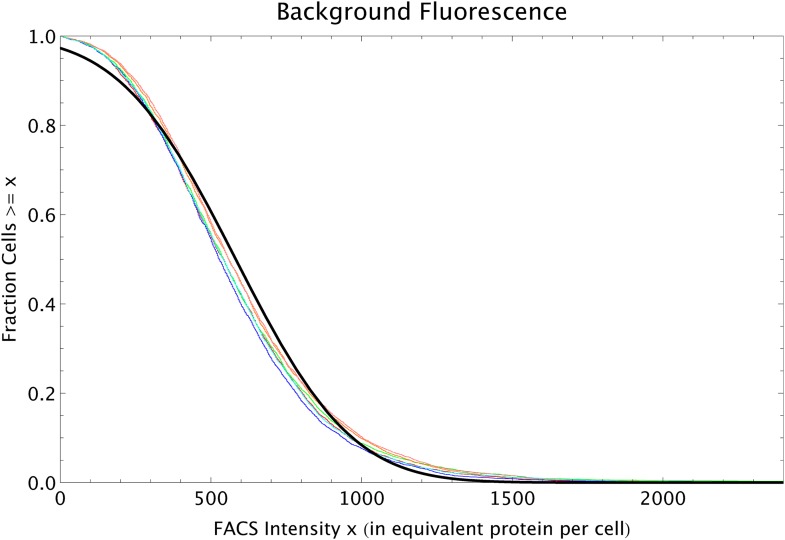
Reverse cumulative distributions of the FACS intensities per cell (multiplied by 2.88 so as to correspond to the equivalent of GFP proteins per cell) for MG1655 cells without a plasmid (red, blue and green curves) and MG1655 cells with an empty plasmid (orange, pink and cyan curves).The black line shows a Gaussian distribution with matching mean and variance.